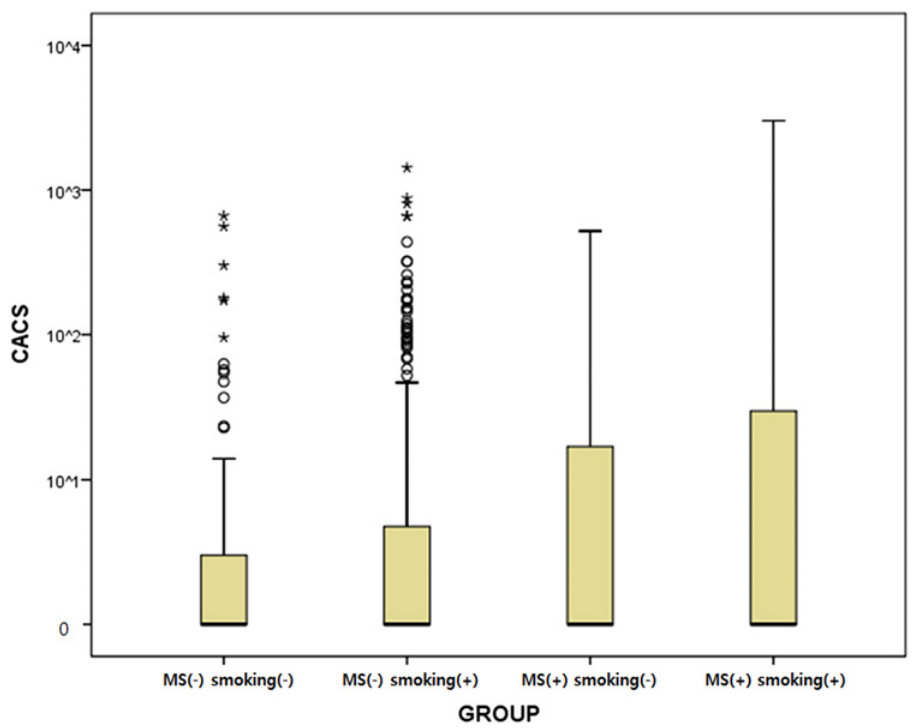
Fig 1. The distribution of Coronary Artery Calcification Score (CACS) according to Metabolic Syndrome (MS) and Smoking Status.